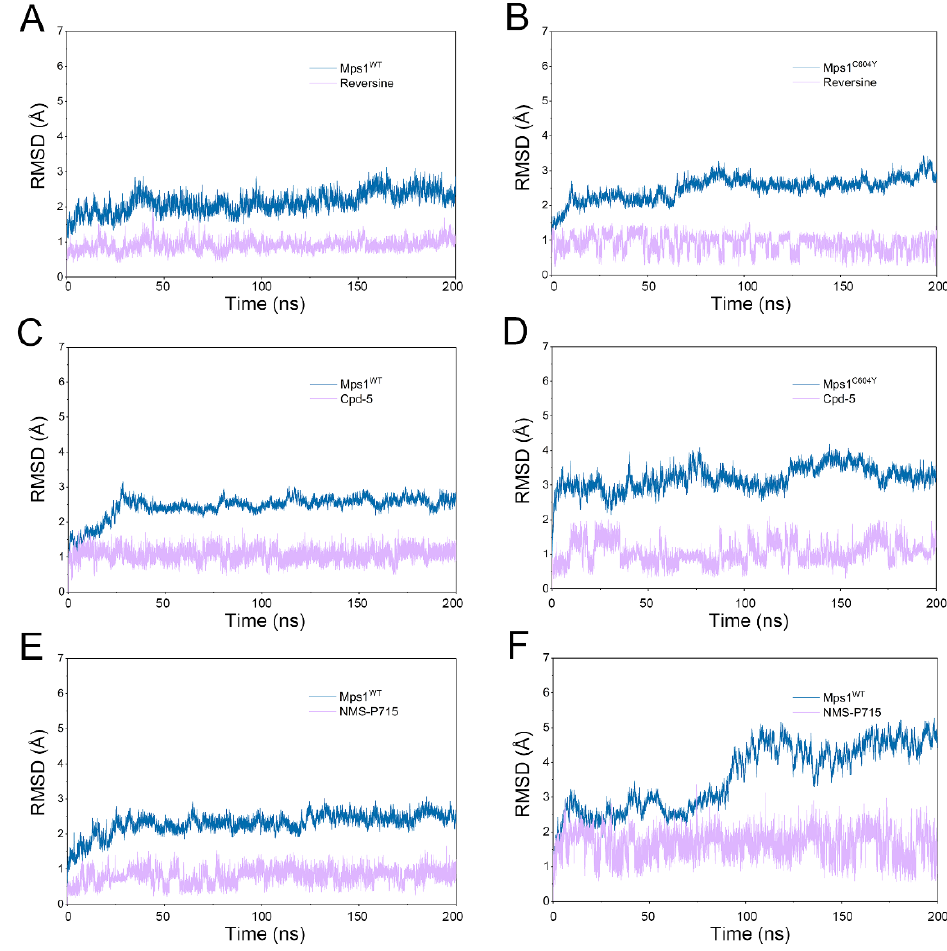
Figure 2. Toot-mean-square deviation (RMSD) analysis of reversine, Cpd-5 and NMS-P715 in Mps1 WT and Mps1 C604Y from classical molecular dynamic (MD) simulations. ( A ) Mps1 WT /reversine; ( B ) Mps1 C604Y /reversine; ( C ) Mps1 WT /Cpd-5; ( D ) Mps1 C604Y /Cpd-5; ( E ) Mps1 WT /NMS-P715; ( F ) Mps1 C604Y /NMS-P715.